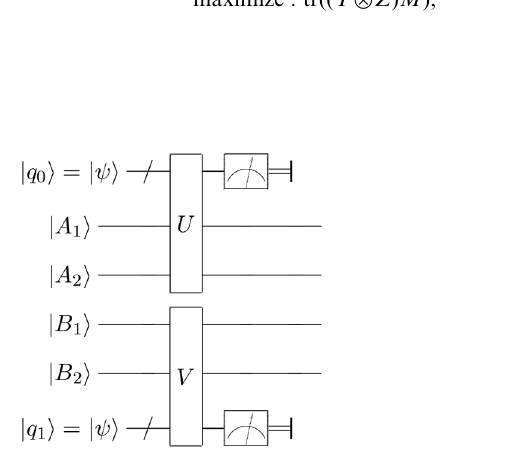
Figure 8. Quantum circuit. A quantum circuit showing the implementation of our scheme. A i and B i denote Alice’s and Bob’s qubits. q 0 and q 1 are the ancillary qubits they need to add.